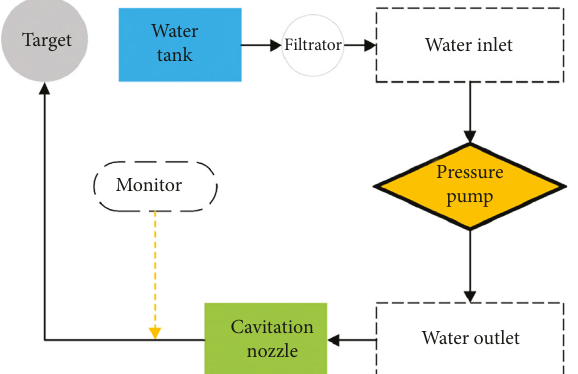
Figure 16: Experimental device of the cavitation